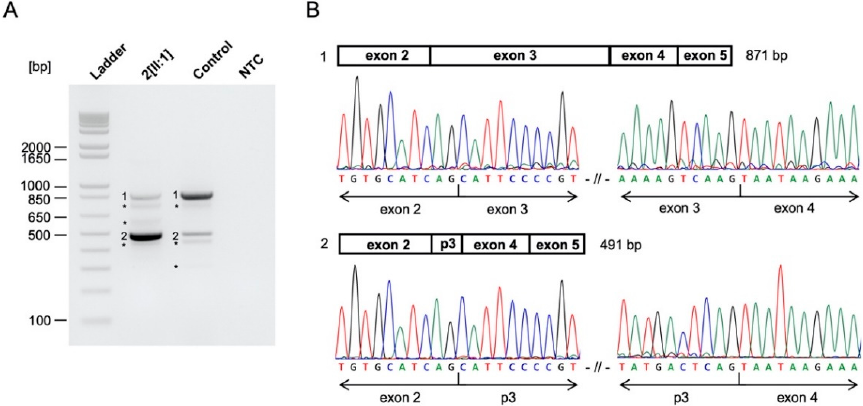
Figure 4. CHD7 c.2095A>G variant alters splicing in functional analysis. ( A ) Agarose gel of RT-PCR products for patient- and control-derived cDNA and the NTC. RT-PCR showed correctly spliced transcript (Fragment 1), partial exon 3 skipping (Fragment 2), and additional nonspecific or alternatively spliced DNA fragments (not sequenced) in index patient 2[II:1] and the control. Partial exon 3 skipping (Fragment 2) was more pronounced in index patient 2[II:1] compared to the control. Ladder, 1 Kb Plus DNA Ladder (Thermo Fisher Scientific); NTC, no template control. * nonspecific or alternatively spliced DNA fragments. ( B ) Schematic overview and Sanger sequencing results of RT-PCR products. Sanger sequencing revealed correctly spliced CHD7 transcript (Fragment 1) and a 380-nt deletion from the 3 (cid:48) end of exon 3 (Fragment 2) due to the CHD7 c.2095A>G variant. p3, partial exon